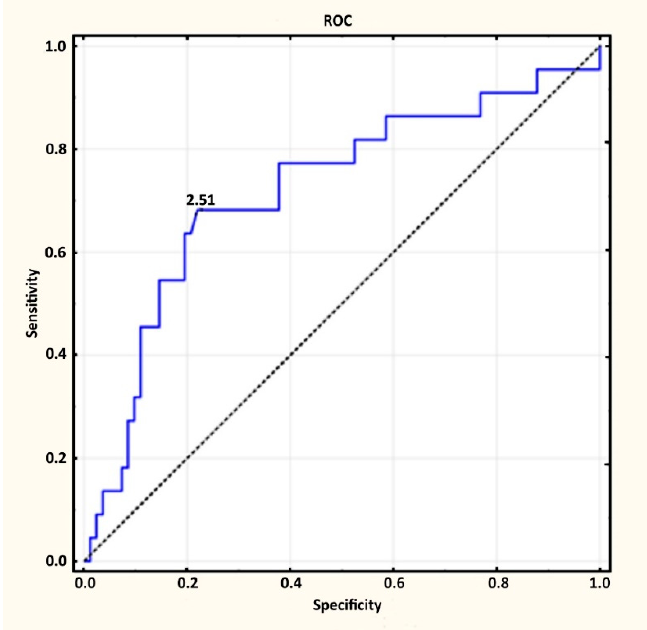
Figure 2. Suggested cut-off point to determine patients with oligometastatic and polymetastatic disease.